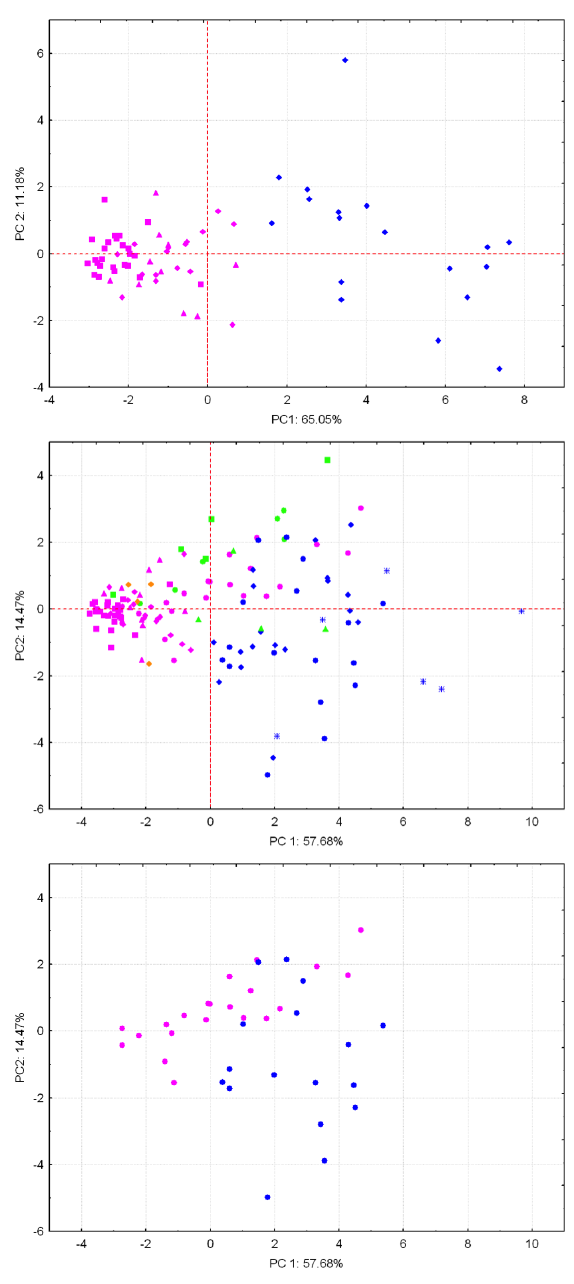
Figure 2. PCA factor score plots of MS peak intensity values for the 14 candidate onchocerciasis biomarkers. Mass feature intensity values were extracted through ESI-TOF + /XCMS analysis of (A) African blood serum and plasma samples from 55 O. volvulus infected individuals compared against 18 healthy controls. (B) A sample set including 76 O. volvulus infected individuals compared against 56 O. volvulus negative controls (including healthy and those infected with other tropical diseases). (C) An extraction of only those data points representing the 21 Guatemala O. volvulus infected individuals compared against 18 healthy controls. Individual data points are symbolized using the following code for country of origin and disease status: ‘‘blue diamond’’=Cameroon Ov 2 , ‘‘blue circle’’=Guatemala Ov 2 , ‘‘blue astrisk’’=Scripps Ov 2 , ‘‘green circle’’=Leishmaniasis Ov 2 , ‘‘green square’’=Chagas Ov 2 , ‘‘green triangle’’=LF Ov 2 , ‘‘pink diamond’’=Cameroon Ov + , ‘‘pink circle’’=Guatemala Ov + , ‘‘pink square’’=Ghana Ov + (1986, 1991 and 2003 samples), ‘‘pink triangle’’= Liberia Ov + , ‘‘orange diamond’’=Cameroon Ov ?.